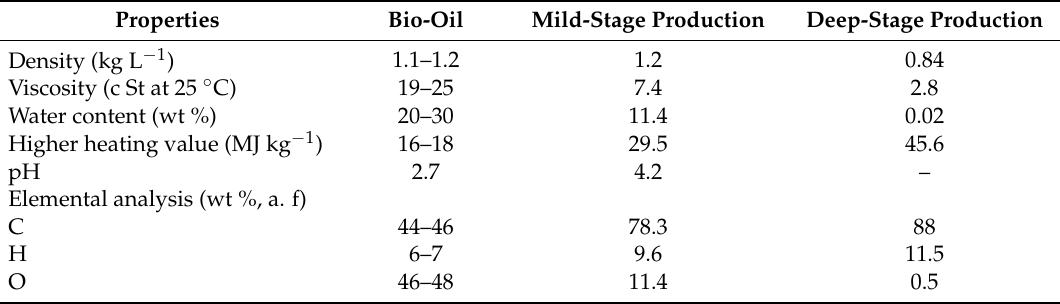
Table 1. Properties of the feedstock and products of the mild and deep stages [9,11,12].